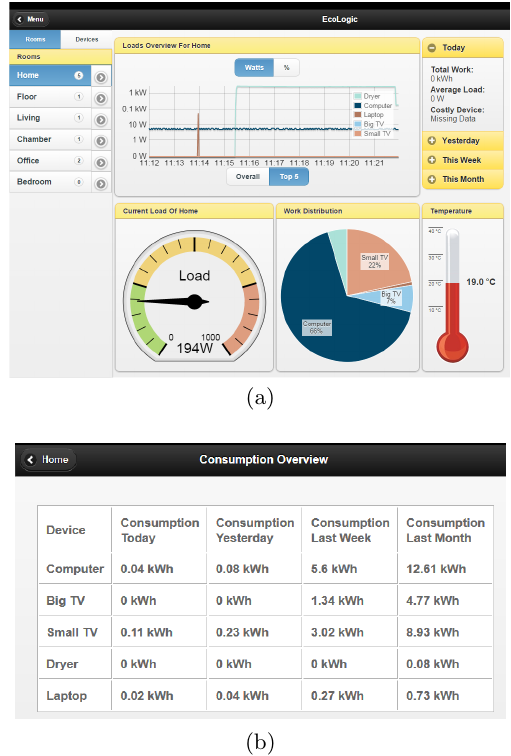
Figure 5: Service 1 with live statistics (a) and Service 2 with long term statistics (b)